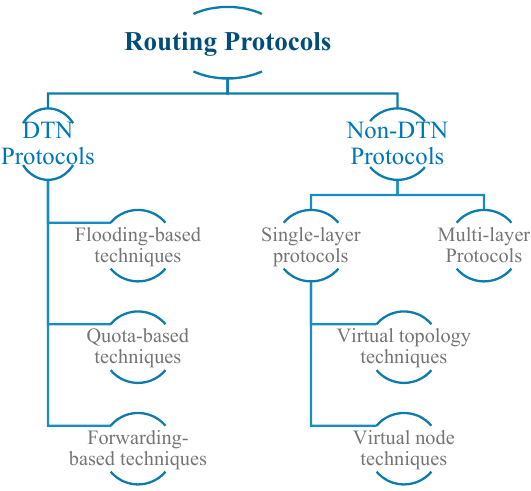
Figure 3. Delay Tolerant (DTN) and Non Delay Tolerant (Non-DTN) routing protocols categories.